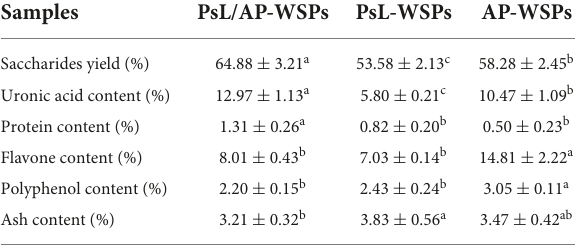
TABLE 1 Chemical components of PsL/AP-WSPs, PsL-WSPs, and